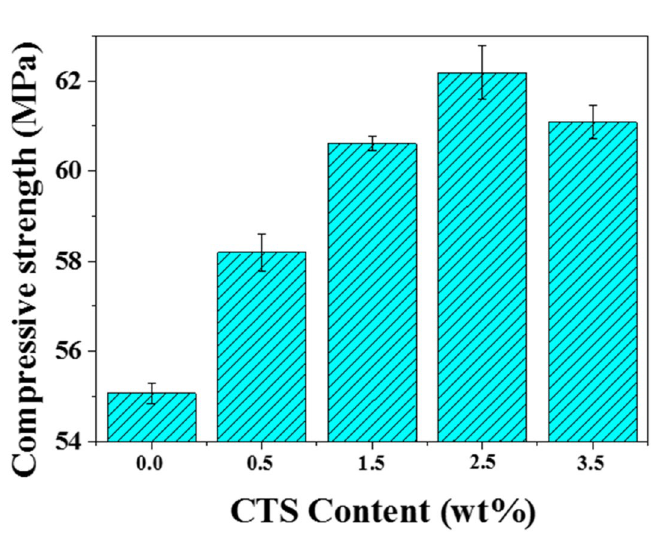
Figure 2. Contact angle images of SS with different CTS content: ( a ) 0.0 wt%, ( b ) 1.5 wt%, ( c ) 2.0 wt%, ( d ) 2.5 wt%, ( e ) 3.0 wt%, ( f ) 3.5 wt%.